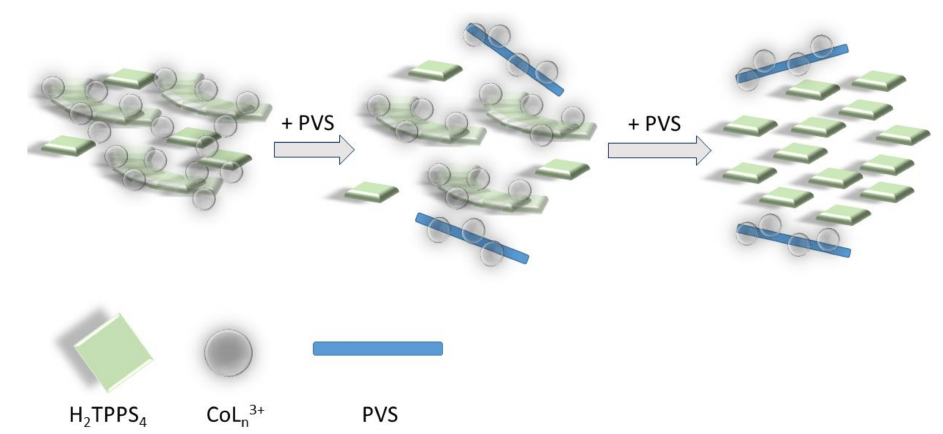
Scheme 3. Pictorial sketch of the disassembling process mediated by the polyanionic PVS: in a first stage the polymer removes the cationic complex bridging monomeric porphyrin units in the J-aggregate mesoscopic structure. In this latter is evidenced the bridging role of cationic metal complexes with respect to H 2 TPPS 4 nano-assemblies and monomeric units. In a second stage, the residual cationic complex is removed, and the J-aggregates disassemble into the constituent porphy- rins.